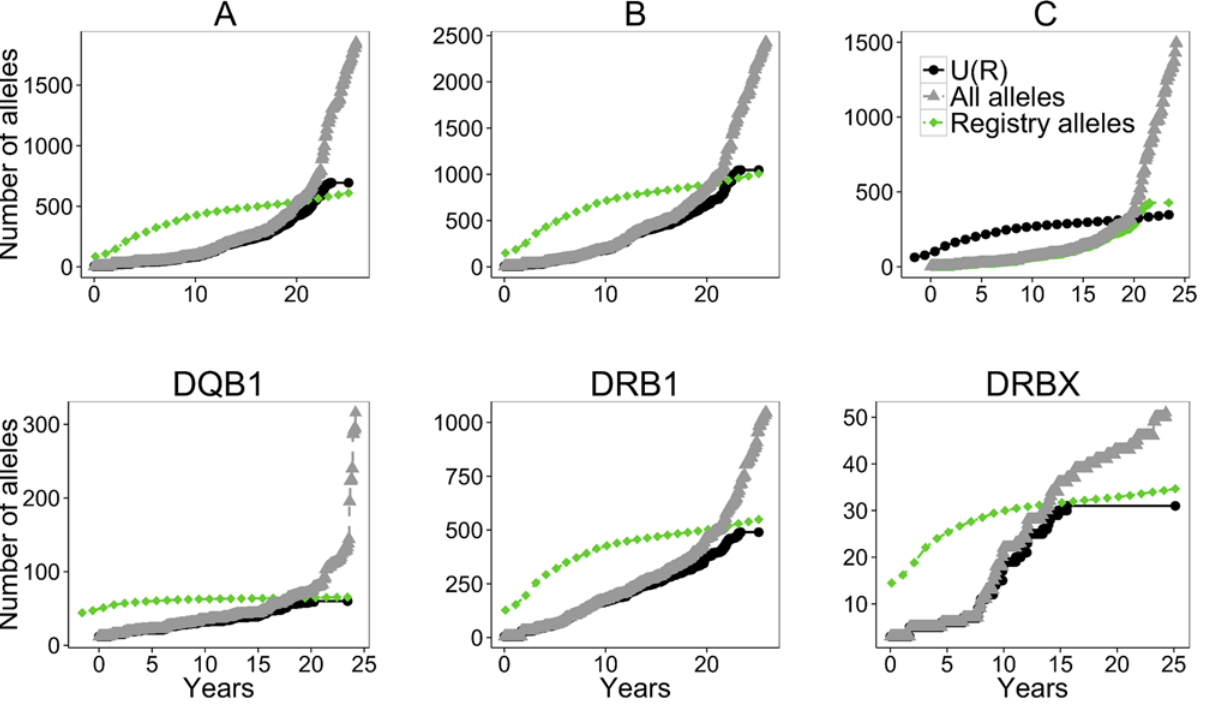
Fig 7. Comparison between expected and observed number of alleles for each locus. The black circles represent the numbers computed from the U ( R ) based estimate. The green diamonds represent the alleles in the registry, the gray triangles represent all alleles in the IMGT. The analysis is on all samples combined. Each subplot represents a different